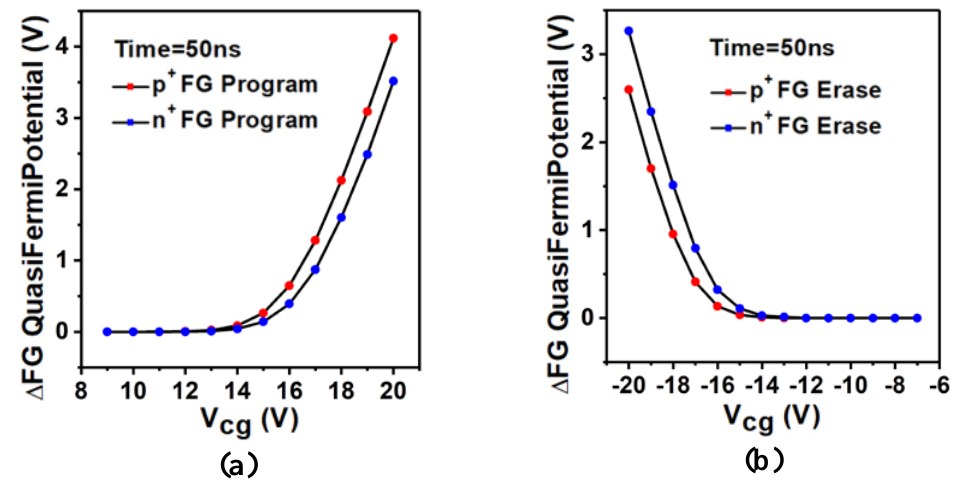
after ( a ) 50 ns after ( a ) 50 ns 𝑉𝑉 𝐶𝐶𝐶𝐶 𝑉𝑉 𝐶𝐶𝐶𝐶